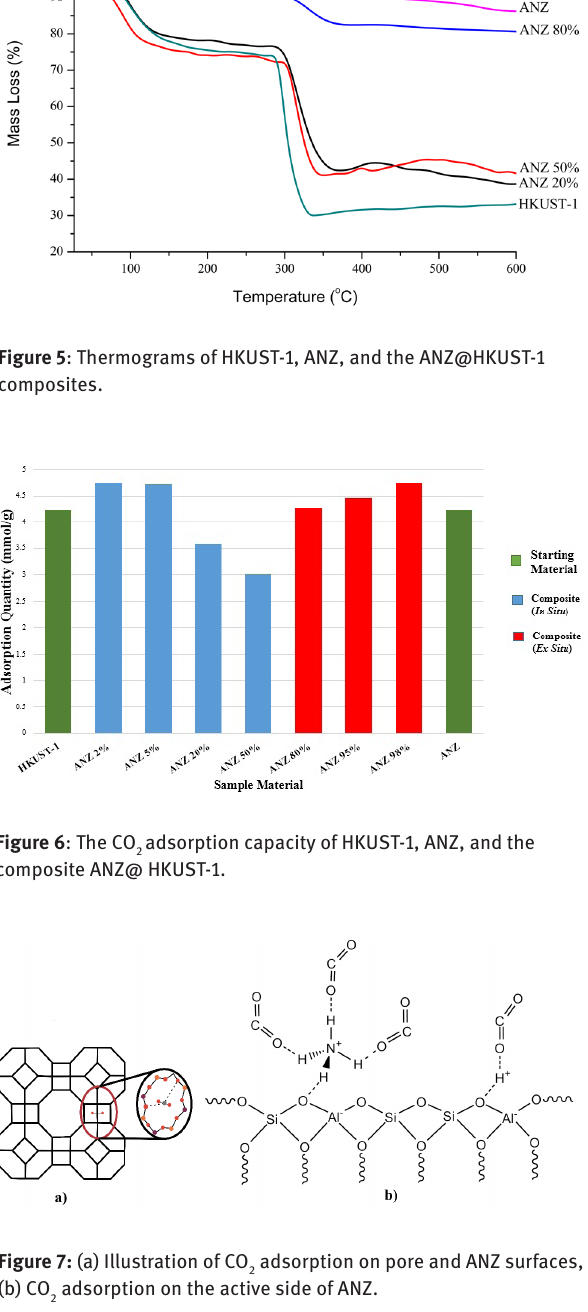
Figure 7: (a) Illustration of CO (b) CO adsorption on the active side of 2